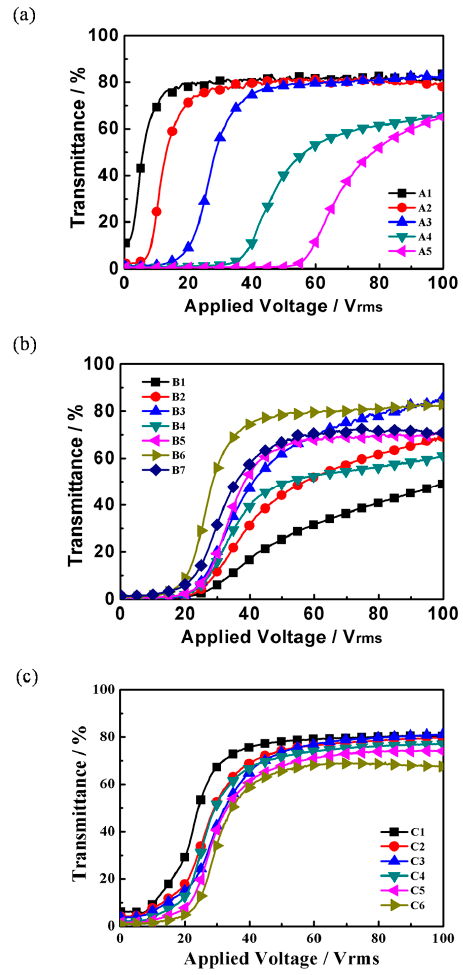
Figure 5. ( a ) The transmittance-applied voltage curves of group A ; ( b ) the transmittance-applied voltage curves of group B ; ( c ) the transmittance-applied voltage curves of group C .